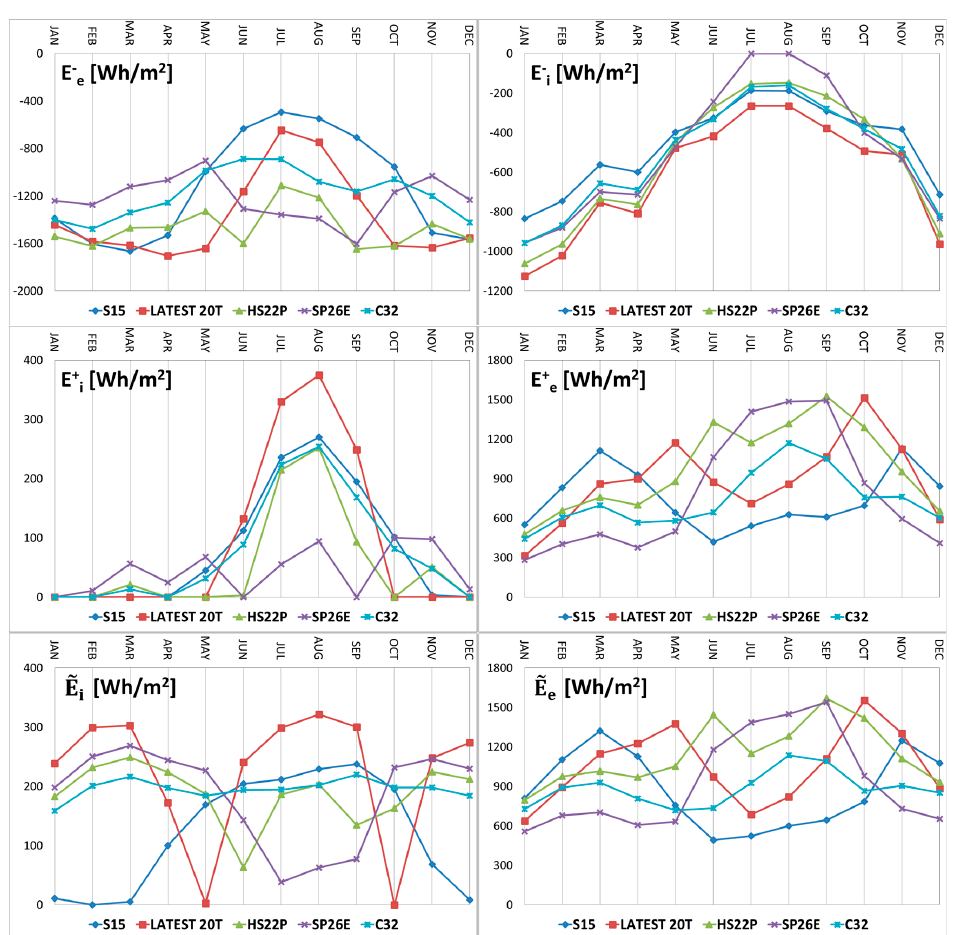
Figure 6. Monthly average daily values of the total energy and of the fluctuating component transferred through the external surface, (cid:1831) (cid:3032) (cid:2878) , (cid:1831) (cid:3032) (cid:2879) and (cid:1831)(cid:3560) (cid:3032) , and through the internal surface, (cid:1831) (cid:3036) (cid:2878) , (cid:1831) (cid:3036) (cid:2879) and (cid:1831) (cid:3560) (cid:3036) , for the different PCMs, Cosenza. In Cosenza, unlike Turin: